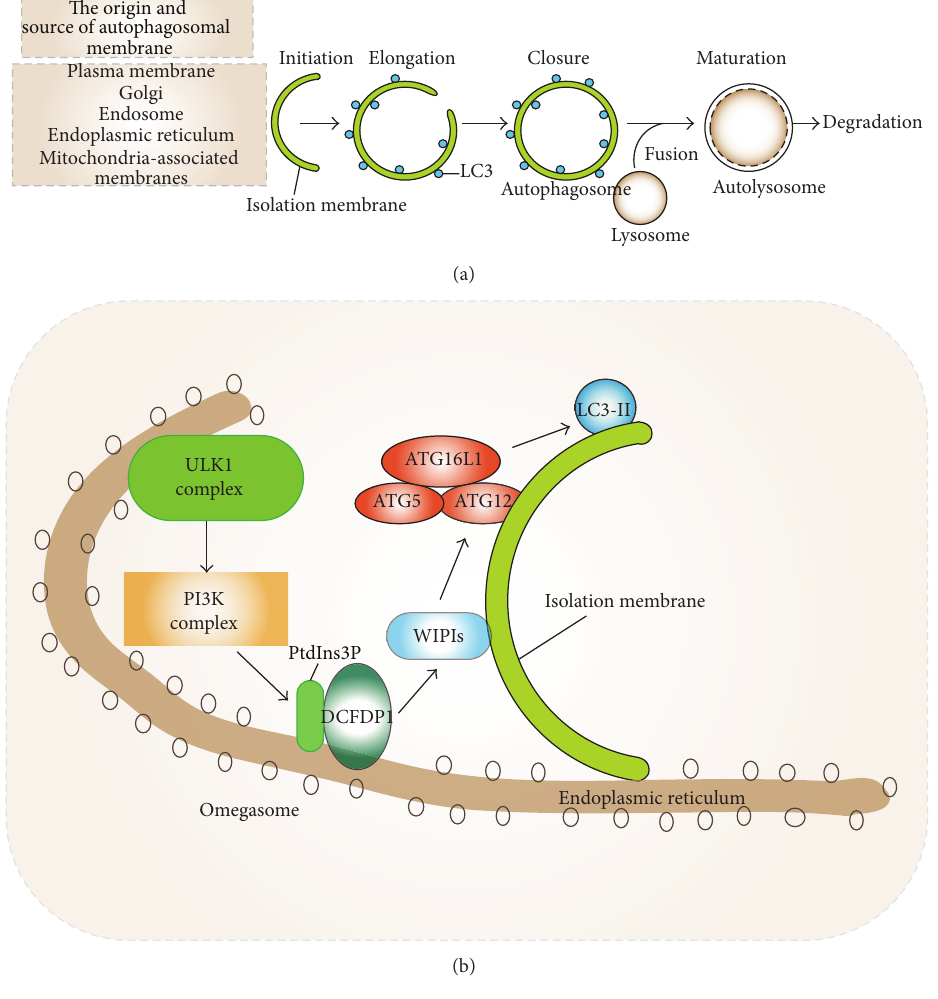
Figure 1: (a) The general scheme of autophagic process is shown. Autophagy is defined as the sequestration of substrates into double- bilayer membrane vesicles termed autophagosomes for degradation. The autophagic process starts with the formation of isolation membrane (phagophore) that originates from various intracellular membrane sources. Initiation of the isolation membrane is followed by elongation and closure leading to a complete autophagosome that surrounds the cargo. The fusion of lysosomes with autophagosomes causes the formation of autolysosomes, where autophagic substrates are exposed to hydrolytic interior of lysosome resulting in their degradation. (b) The molecular representation of autophagy initiation is shown at phosphatidylinositol-3-phosphate- (PtdIns 3 P-) positive membrane structures named “omegasomes.” The induction of autophagy translocates ULK1 complex to the endoplasmic reticulum leading to activation of the PtdIns 3 P kinase (VPS34/Beclin-1/ATG14L) complex. VPS34-derived PtdIns 3 P recruits double FYVE-containing protein 1 (DFCP1/ZFYVE1) and WD-repeat protein interacting with phosphoinositides (WIPIs) to the outer membrane of autophagosomes causes the association of the ATG5/ATG12 conjugate with ATG16L1. The ATG5/ATG12/ATG16L1 complex then adds phosphatidylethanolamine group to the C-terminus of the LC3 protein promoting the elongation of isolation